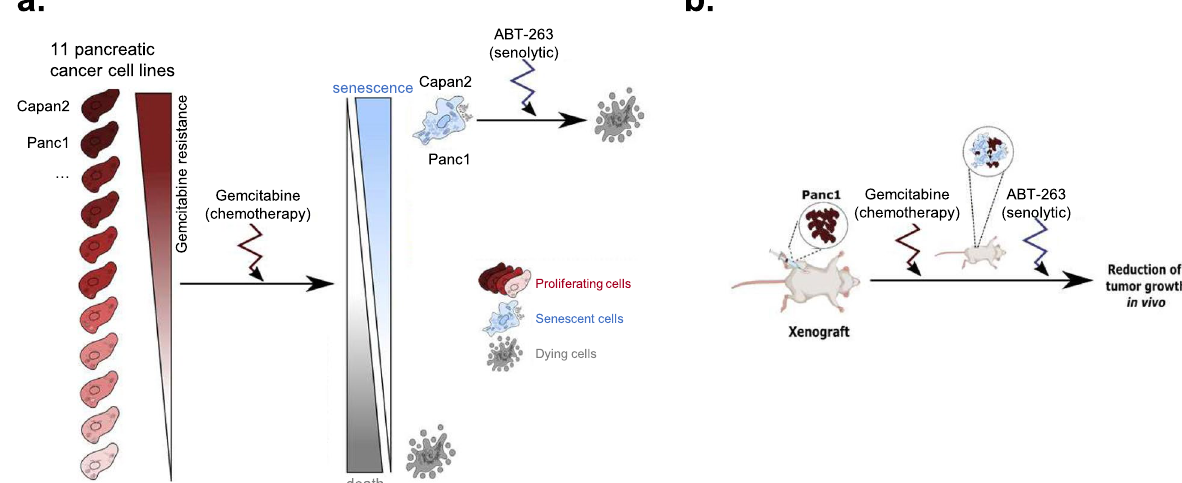
24), gemcitabine ( n 25), ABT‑263 ( n 23) or gemcitabine = = =